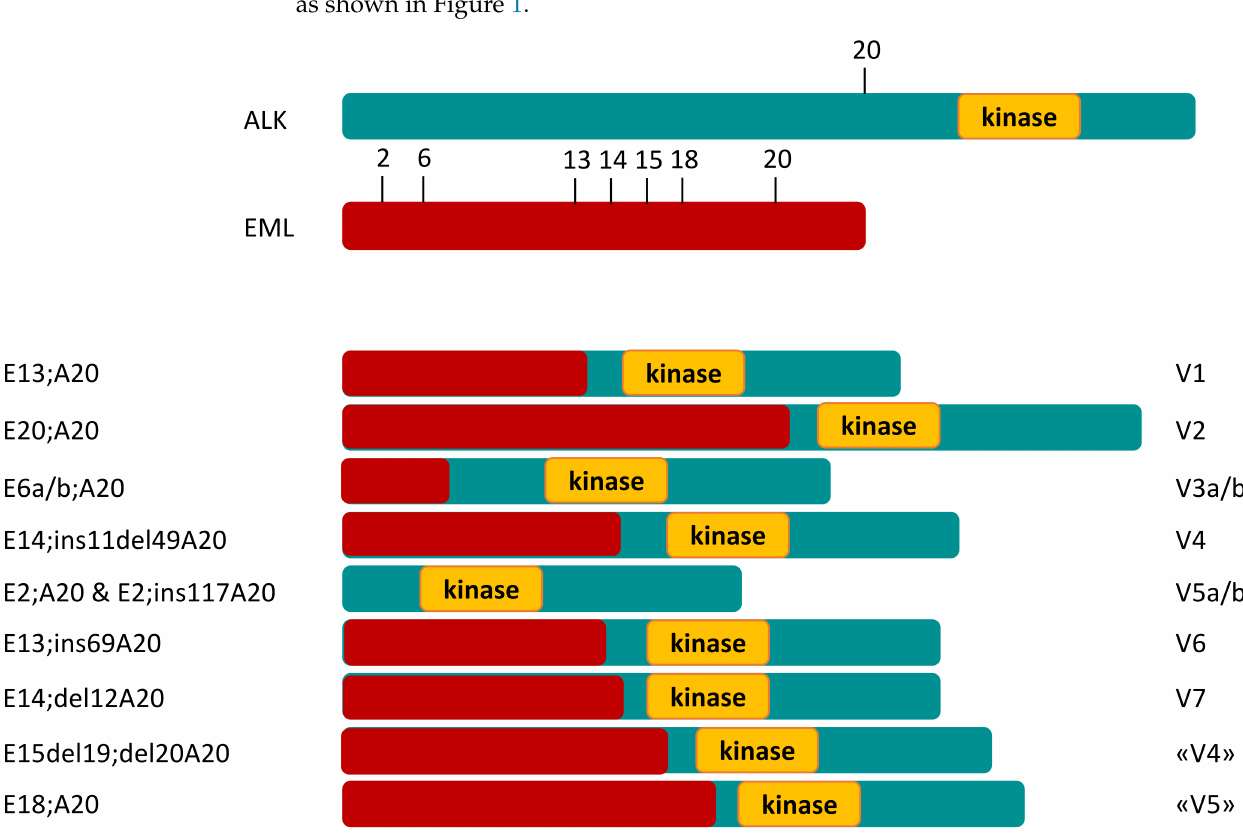
Figure 1. Alternative splicing leads to several variants of EML4–ALK fusion